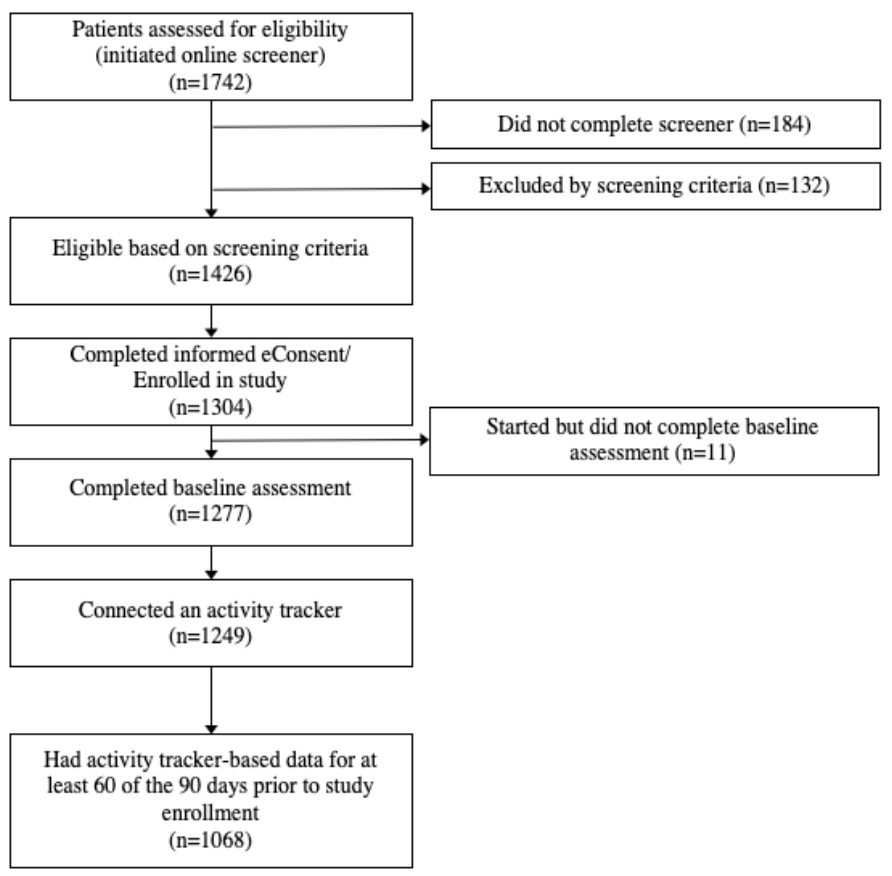
Figure 1. Study flow.